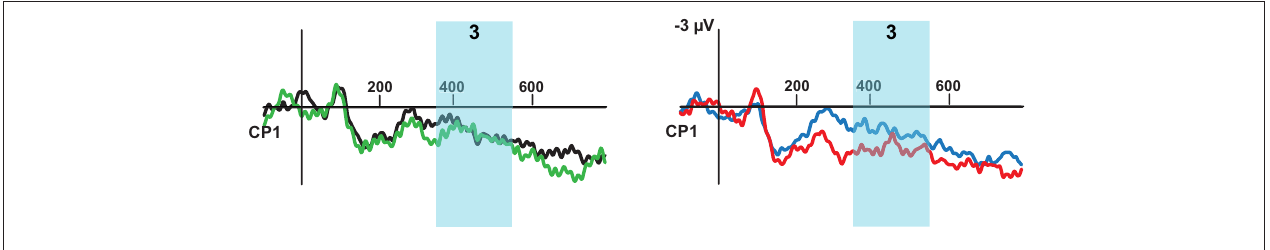
FiguRE 4 | N400 effect for Veracity shown for a representative electrode (cP1). The left panel shows the false (black) and true (green) sentences in matched modality contexts; the right panel shows the false (blue) and true (red)